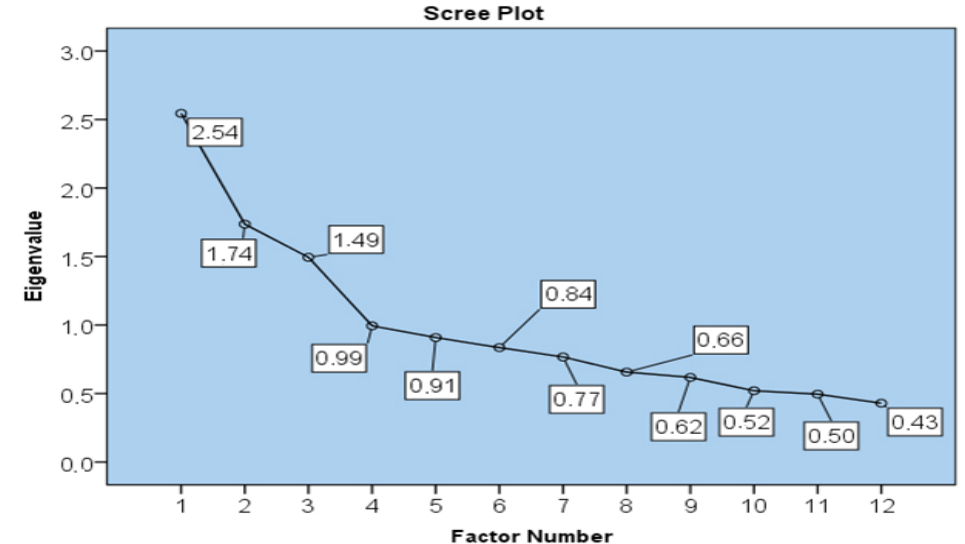
Figure 1. Sedimentation values. Source: own elaboration.